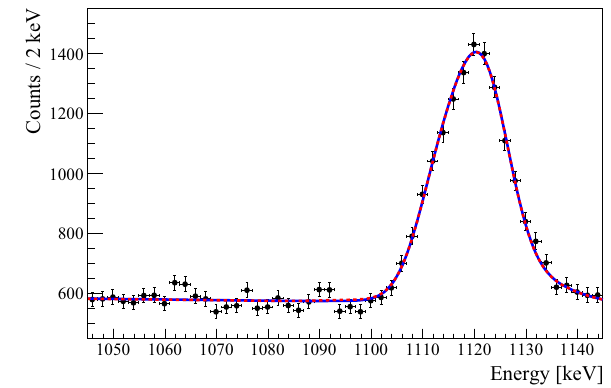
Fig. 4 Result of the fit of signature C. The signal is expected at E = 1094.9keV. We modelled the background using an exponentially decreasing background and a peaking background due to 65 Zn. Dotted line: a hypothetical signal corresponding to the 90% CI limit set in this work